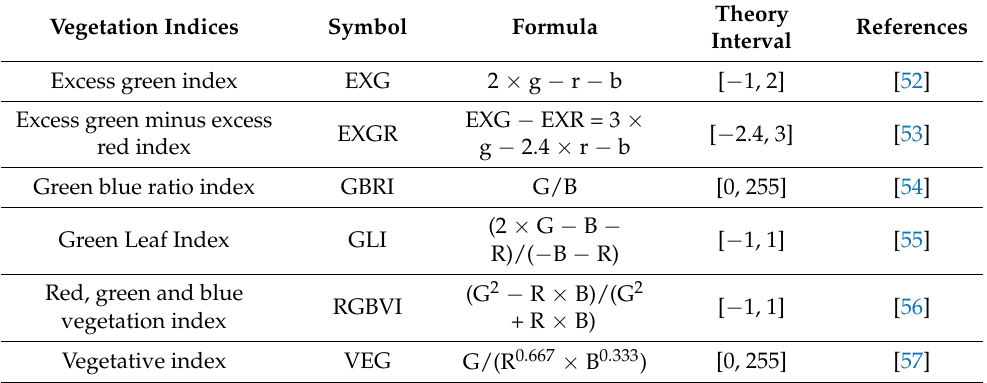
Table 1. RGB VIs used in the study. Vegetation Indices Symbol Formula